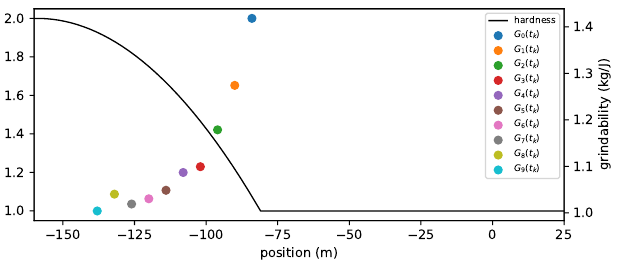
Figure 16. The backtracked grindability at 10 individual blocks at the left source shown together with the hardness profile. As can be expected, these are inversely